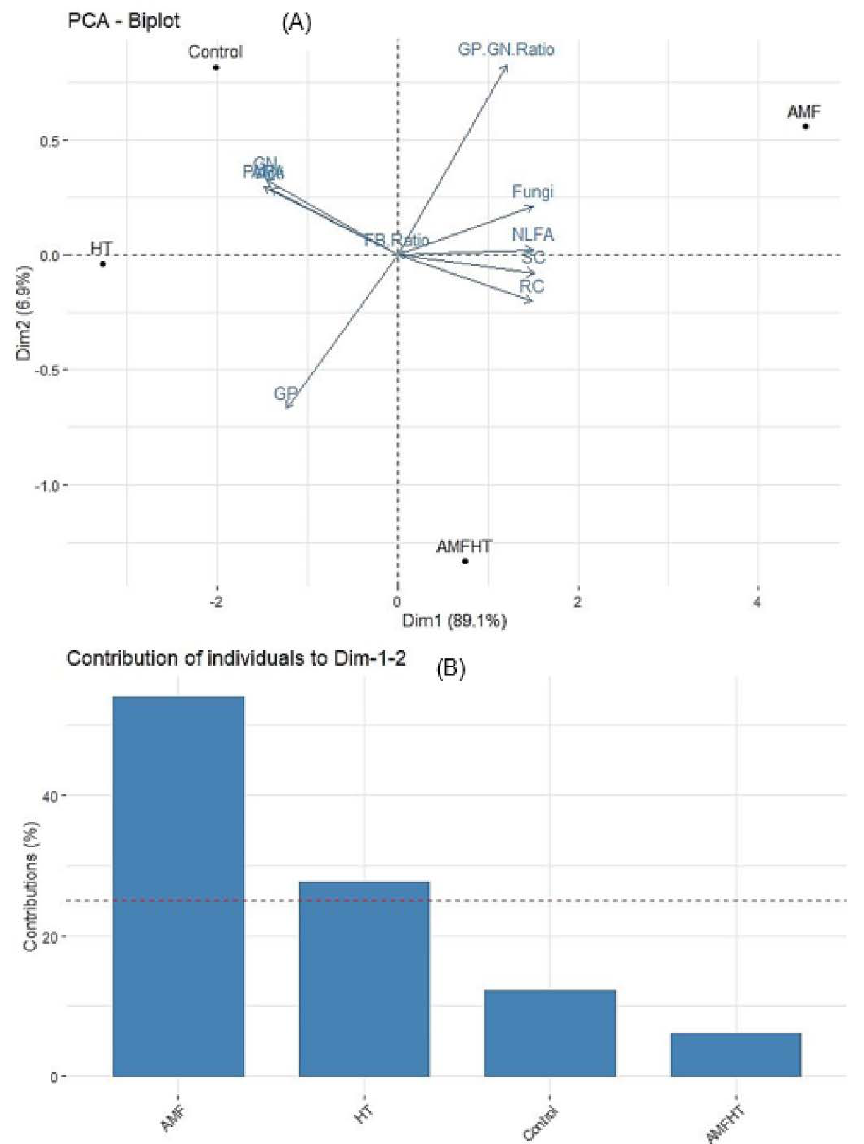
Figure 4. ( A ) PCA score plot for the treatments and parameters (AMF biomass and microbial communities). The percent values that indicate the variation contributed by each PC are dis- played in parentheses. The highest contribution was made by the parameters present in the right (Table S1). ( B ) Graphical illustration of individual contribution of the treatments to